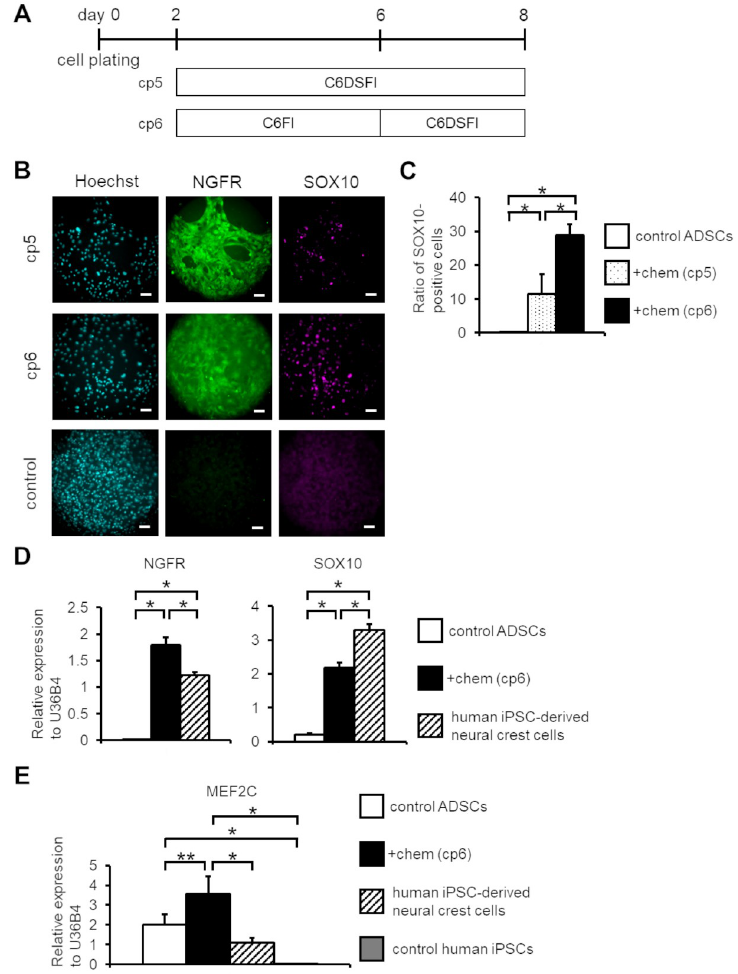
Fig 2. Optimizing chemical induction methods to induce SOX10 expression in human ADSCs. (A) Schematic of the cell induction methods. Two combinations of small molecular cocktails (cp5, 6) were tested on human ADSCs. (B) Immunofluorescent analysis of NGFR and SOX10 expression in control and chemical-treated human ADSCs. Immunofluorescent analysis was performed on day 8 samples. Scale bar; 100 μ m. (C) Ratio of SOX10-positive cells to Hoechst-positive cells in control ADSCs and chemical (the cp5 and cp6 condition)-treated ADSCs at day 8 by immunofluorescent analysis. ( n = 4, error bar shows SDs; one-way ANOVA Tukey post-test). (D) qPCR analysis of NGFR and SOX10 expression among control ADSCs, chemical (the cp6 condition)-treated ADSCs on day 8, and human iPSC-derived neural crest cells. The expression values were normalized to that of U36B4. ( n = 3, error bar shows SDs; one-way ANOVA Tukey post-test). (E) qPCR analysis of MEF2C in control ADSCs, chemical (the cp6 condition)-treated human ADSCs on day 8, human iPSC-derived neural crest cells, and control human iPSCs. The expression values were normalized to that of U36B4. ( n = 3, error bar shows SDs; one-way ANOVA Tukey post-test). C; CHIR, 6; E-616452, F; FSK, D; DM, S; SB, and I; ISX9. � P < 0.01, �� P < 0.05.